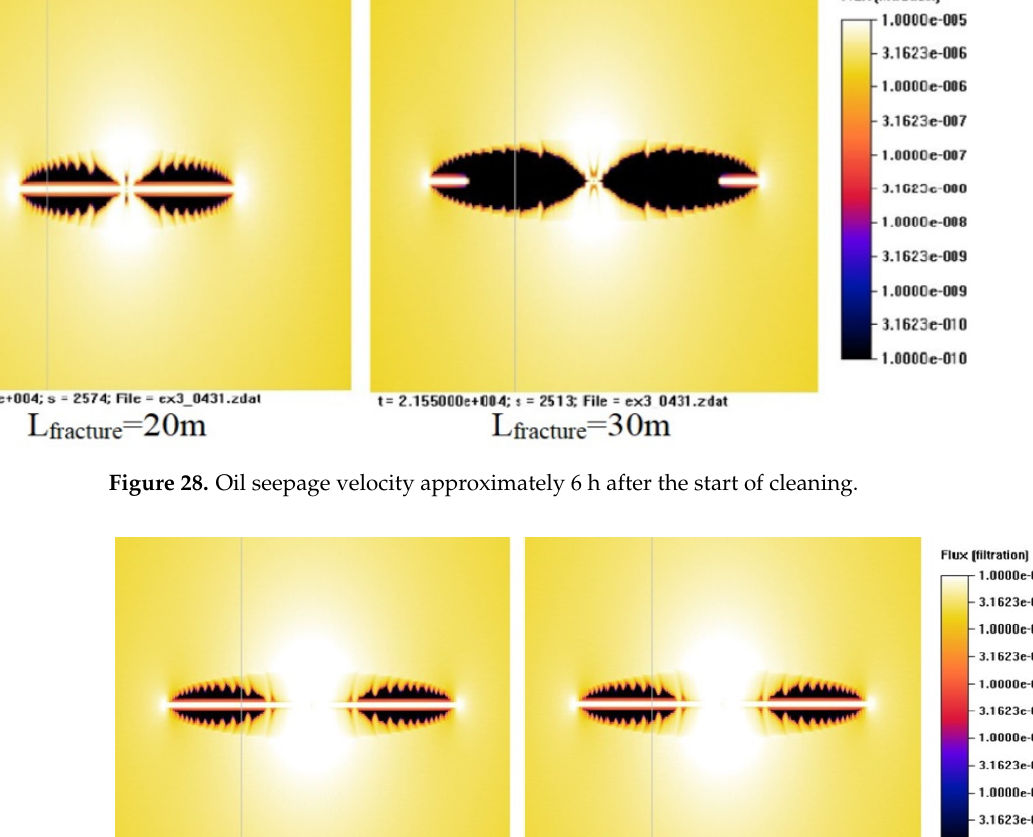
Figure 29. Oil seepage velocity in approximately 15 h after the start of cleaning.